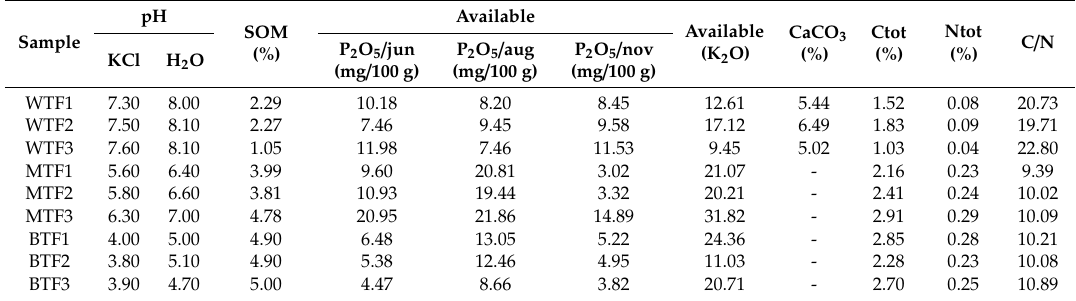
Table 1. Selected parameters of soil fertility in each sampling plot (WTF-white tru ffl e forest, MTF mixed tru ffl e forest, BTF black tru ffl e